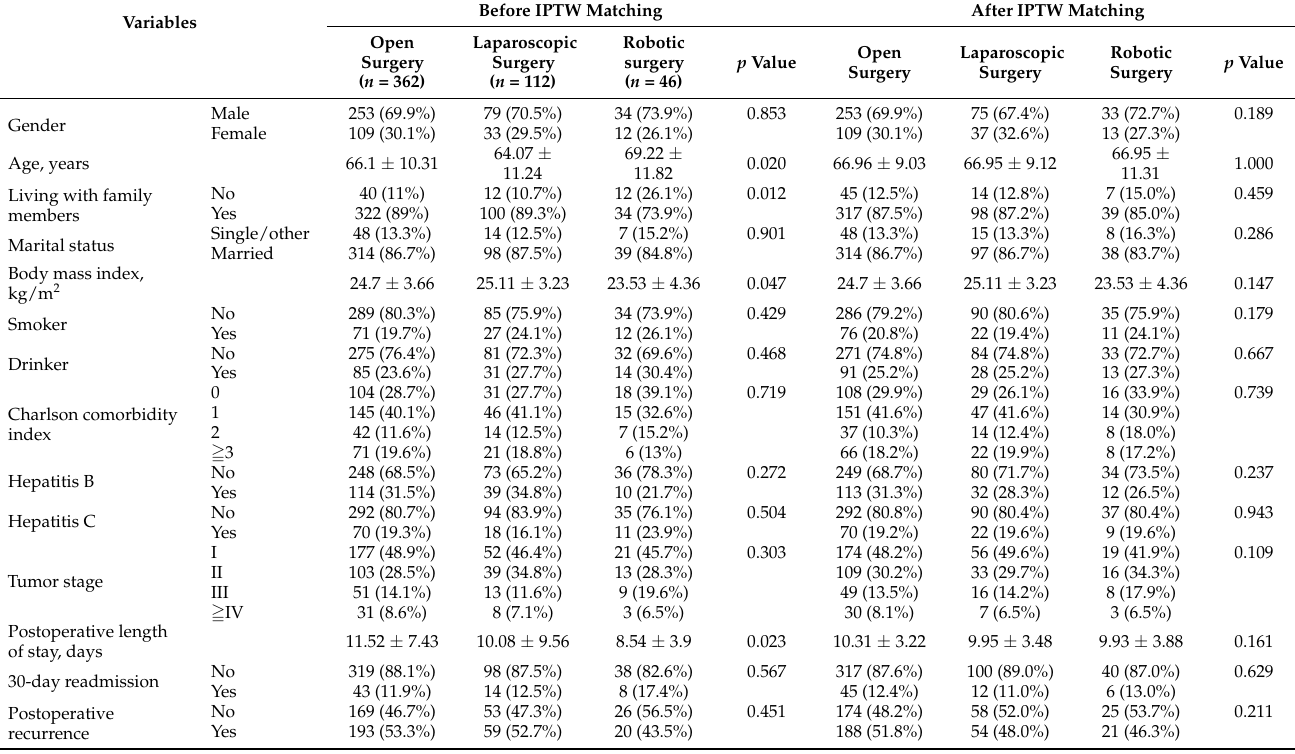
Table 1. Hepatocellular carcinoma patient characteristics compared among the three surgical proce- dures before and after matching by inverse probability of treatment weighting